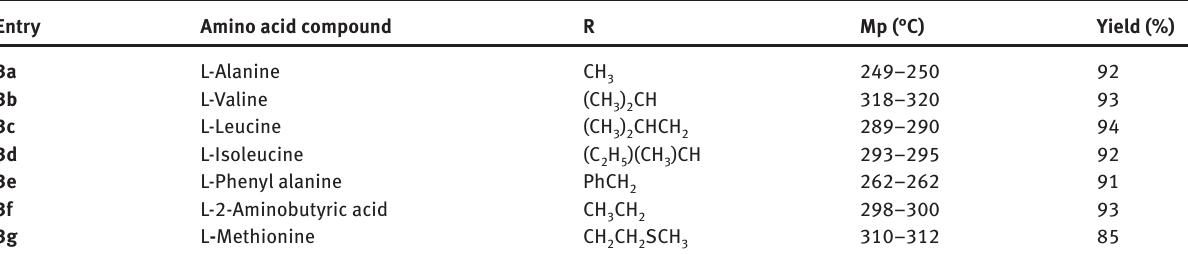
Table 1: Some physical properties of diimide-diacid derivatives